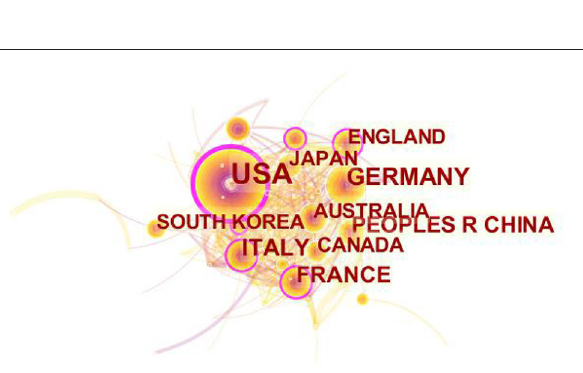
FIGURE 3 | Country visualization map.